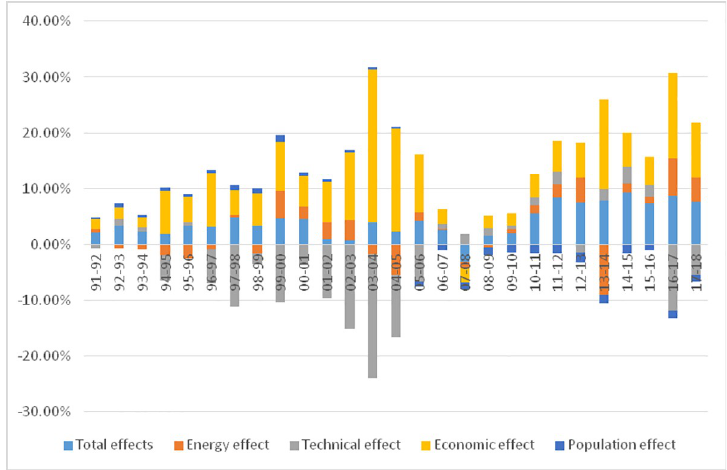
Fig 2. The contribution rate of each effect in the change of agricultural carbon emission in